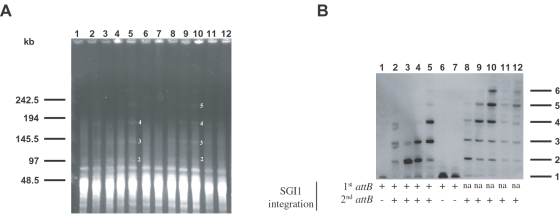
Copy numbers of SGI1 tandem arrays in the S. Typhimurium LT2 chromosome.(A) Macrorestriction analysis by PFGE of genomic DNAs cut by AscI of S. Typhimurium LT2 SGI1 transconjugants. Lanes: 1, S. Albany strain 7205.00 (SGI1 donor strain); 2-7, S. Typhimurium LT2 SGI1 transconjugants; 8-12, ΔthdF mutant S. Typhimurium LT2 SGI1 transconjugants. The molecular sizes in kilobases are indicated to the left of the panel. The numbers indicated to the right of the bands on the restriction patterns (lane 5 and 10) correspond to the copy numbers of SGI1 in each fragment. The size of the AscI fragments observed are consistent with the expected sizes of 2 to 5 SGI1 copies in tandem. (B) Southern blot hybrization with the p1-9 probe of the PFGE-AscI restriction patterns of Figure 4A. The numbers indicated to the right of the panel correspond to the copy numbers of SGI1 in each fragment revealed by the p1-9 probe. The integration sites of SGI1 are indicated under each transconjugant profiles; (+) integrated SGI1, (−) unoccupied attB site, (na) not applicable.